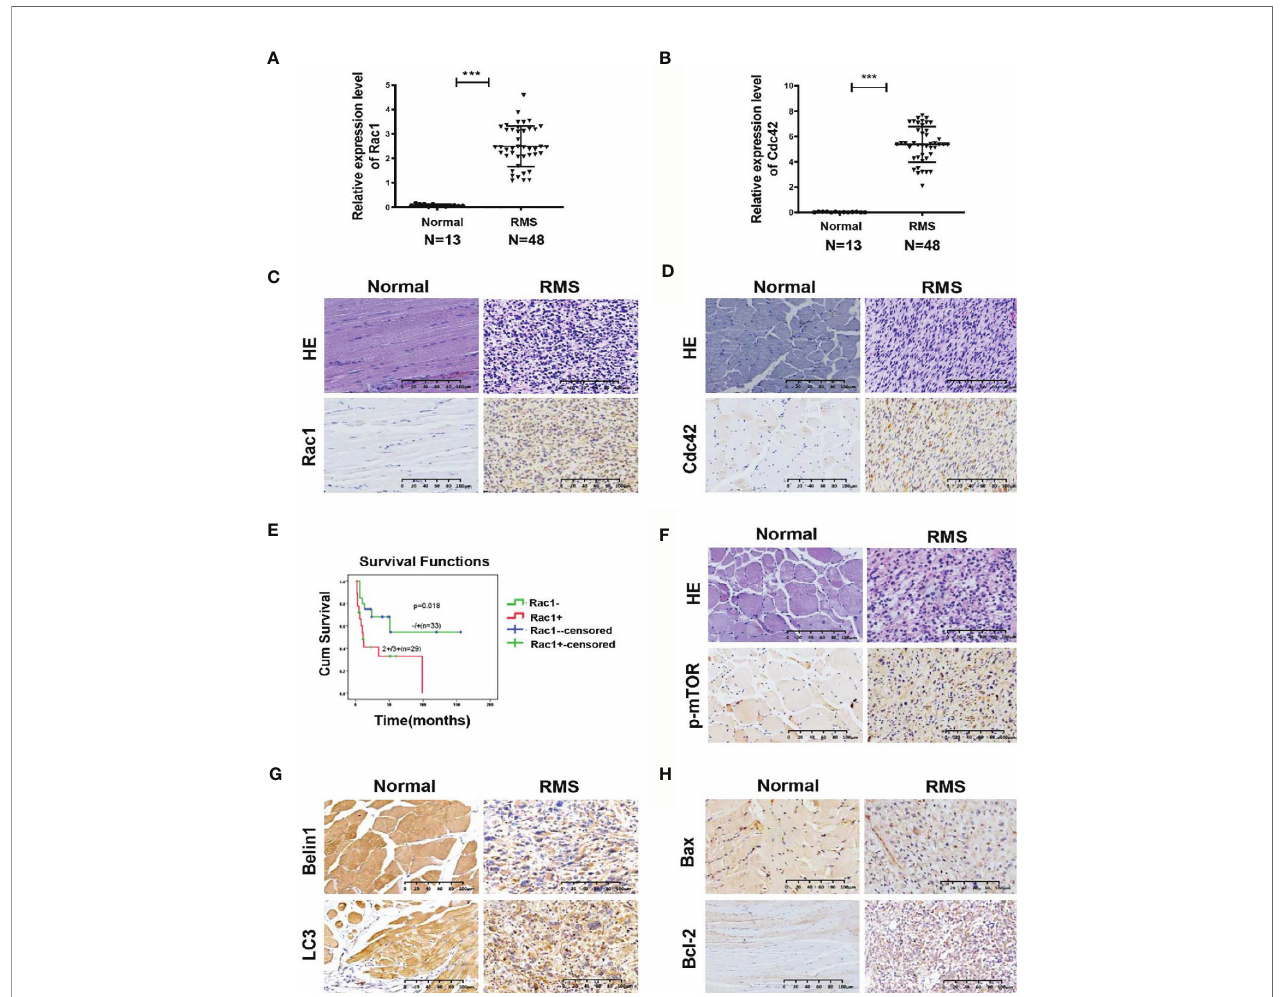
FIGURE 1 | Expression of Rac1, Cdc42, p-mTOR, and autophagy- and apoptosis-related molecules in RMS tissues. (A, B) Quantitative real-time PCR (qRT-PCR) was used to detect the mRNA expression levels of Rac1 (A) and Cdc42 (B) in 48 RMS cases and 13 normal muscle tissue cases. (C, D) HE and IHC staining of Rac1 (C) and Cdc42 (D) in normal and RMS tissues. (E) Kaplan – Meier analysis and log-rank test were applied to determine the relationship between Rac1 protein expression and patient survival. (F) HE and IHC staining of p-mTOR in normal and RMS tissues. (G) IHC staining of Beclin1 and LC3 in normal and RMS tissues. (H) IHC staining of Bax and Bcl-2 in normal and RMS tissues. A representative image is provided. ***P <